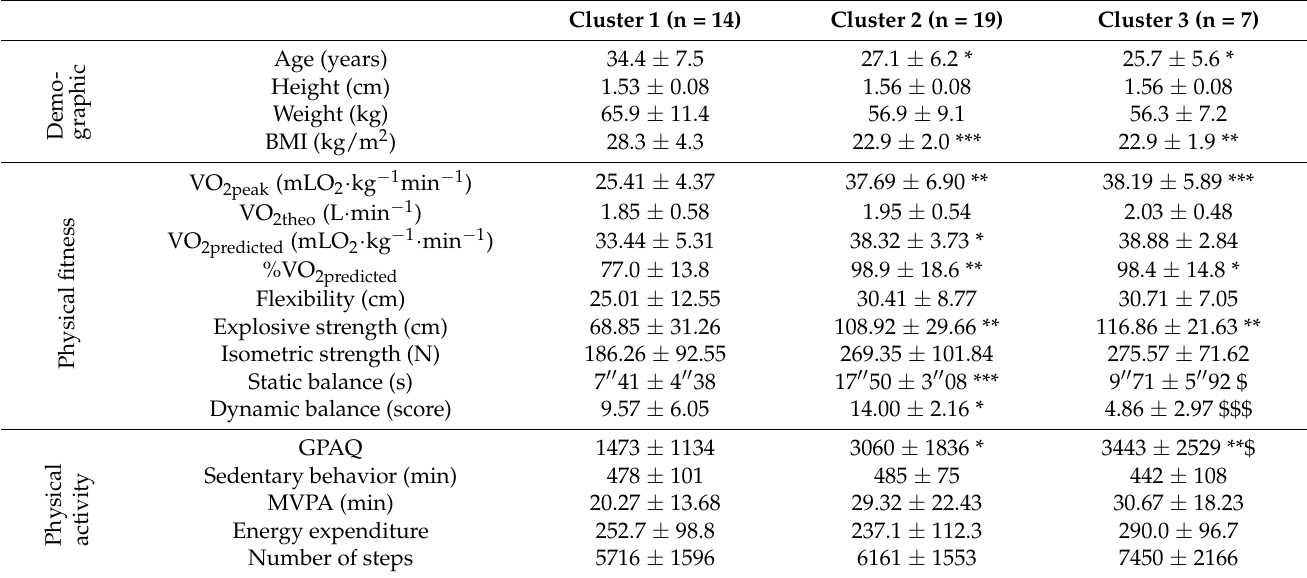
Table 2. Participants’ anthropometric characteristics, physical fitness and PA assessment related to physical activity